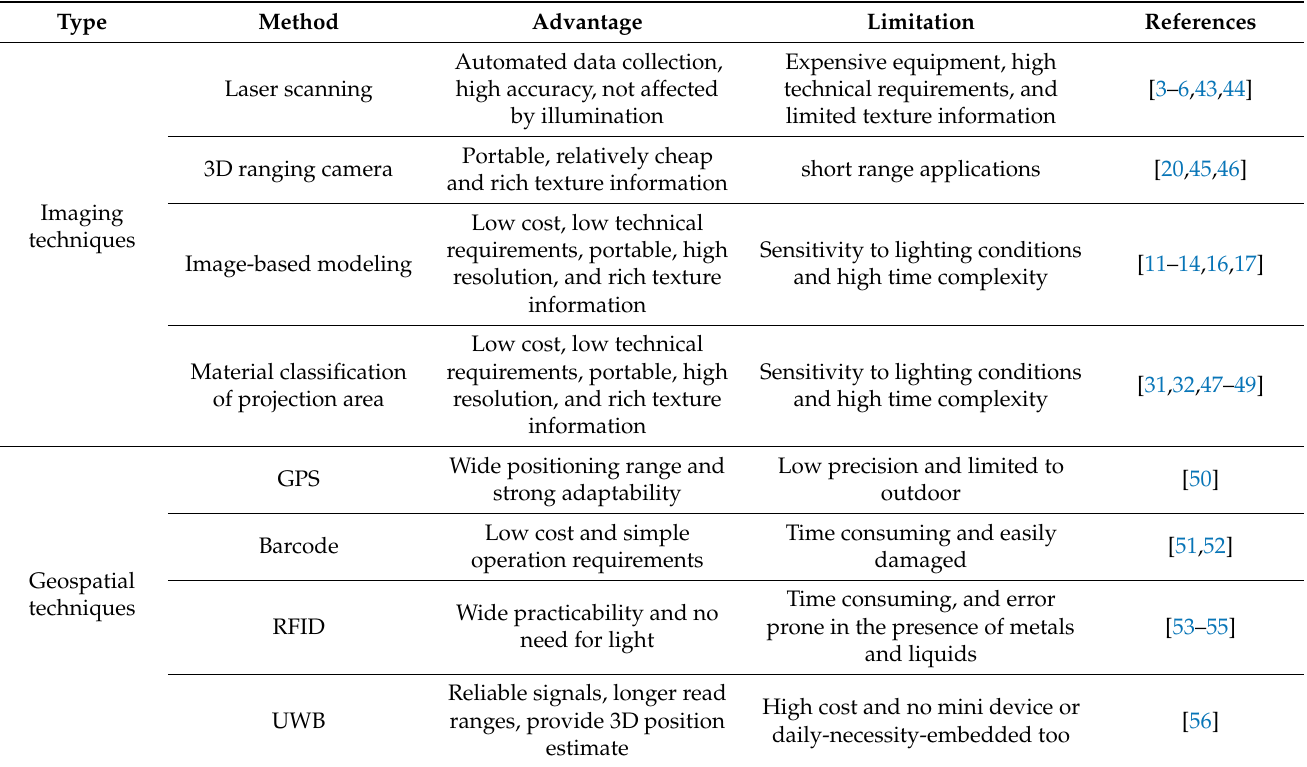
Table 1. Automatic construction progress